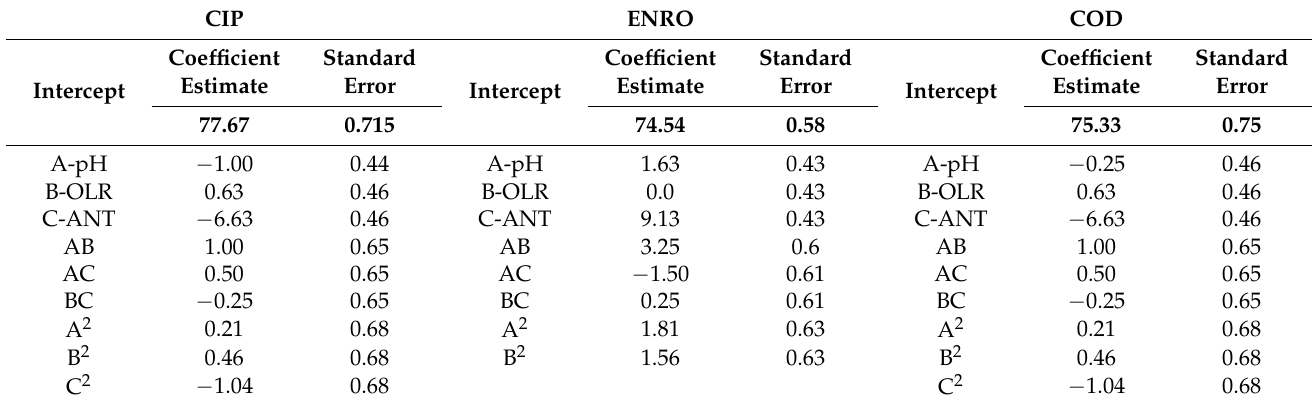
Table 3. Model coefficient estimation.